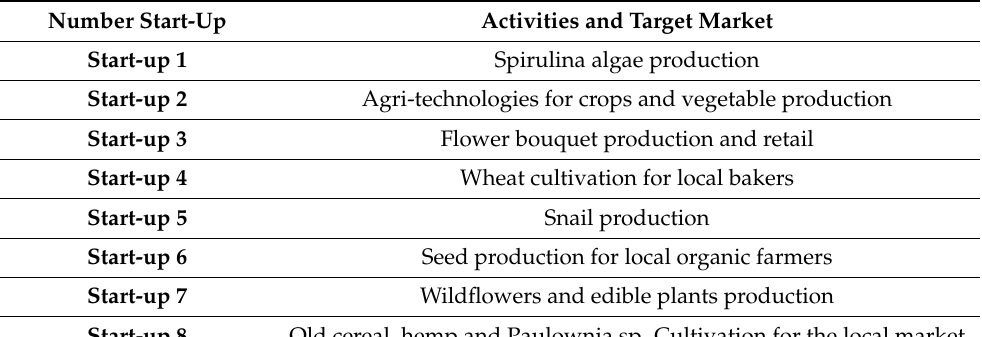
Table 2. List of start-ups working in the OpenAgri area and description of activities.